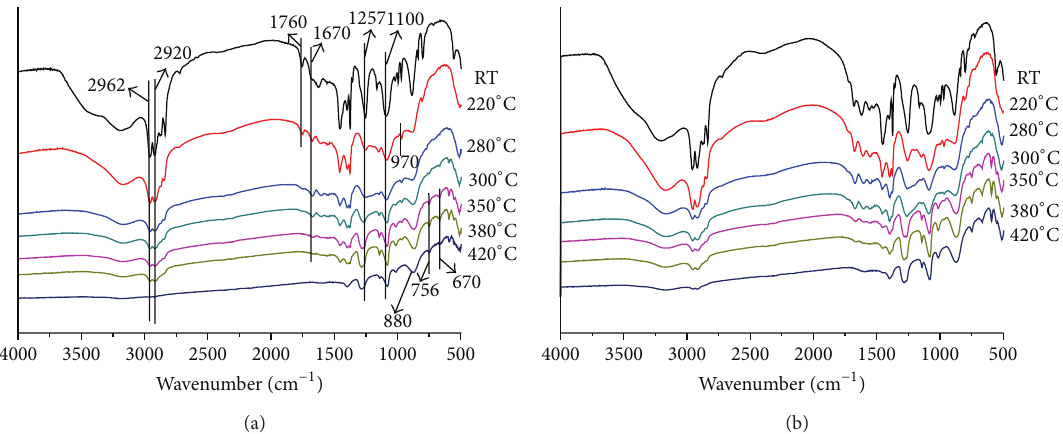
Figure 7: RTFTIR spectra at different pyrolysis temperature: (a) PP0, (b) PP2.